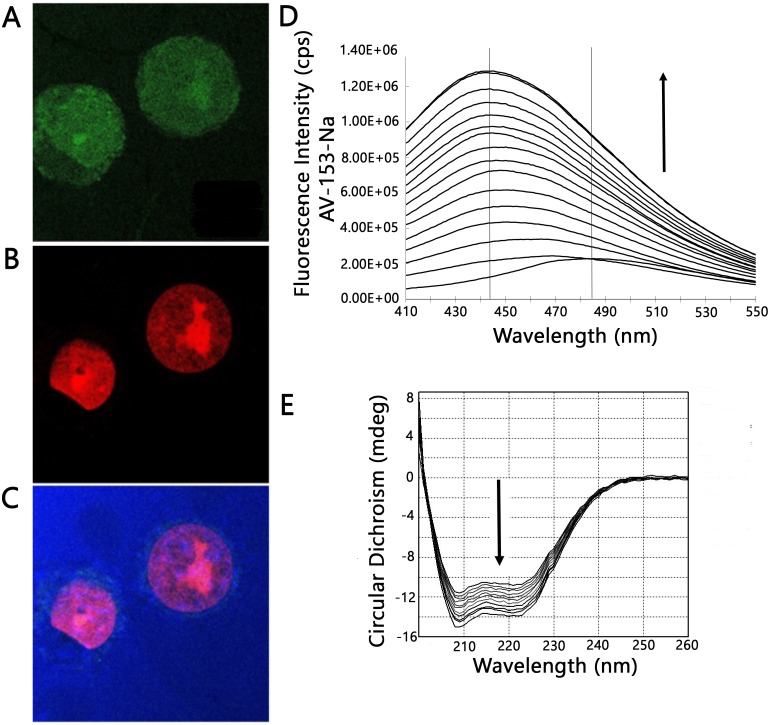
Confocal microscopy and protein binding assay.(A–C) images of HeLa cells obtained by laser scanning confocal microscopy. Cells were treated with AV-153-Na, DNA was stained with propidium iodide (PI). Light blue—reflected light; (A) green—distribution of AV-153-Na; (B) red—propidium iodide; the overlay image (C) of all channels. Pictures of the optical section were taken 3 µm from the cell surface. All the scale bars are in 7.5 µm size. (D) Fluorescence titration of AV-153-Na with human serum albumin (5 µM each time). (E) Circular dichroism spectra of HSA in absence and presence of AV-153-Na. AV-153-Na concentration was increased by 1 µM at each step up to 12 µM. HSA concentration was 300 nM.